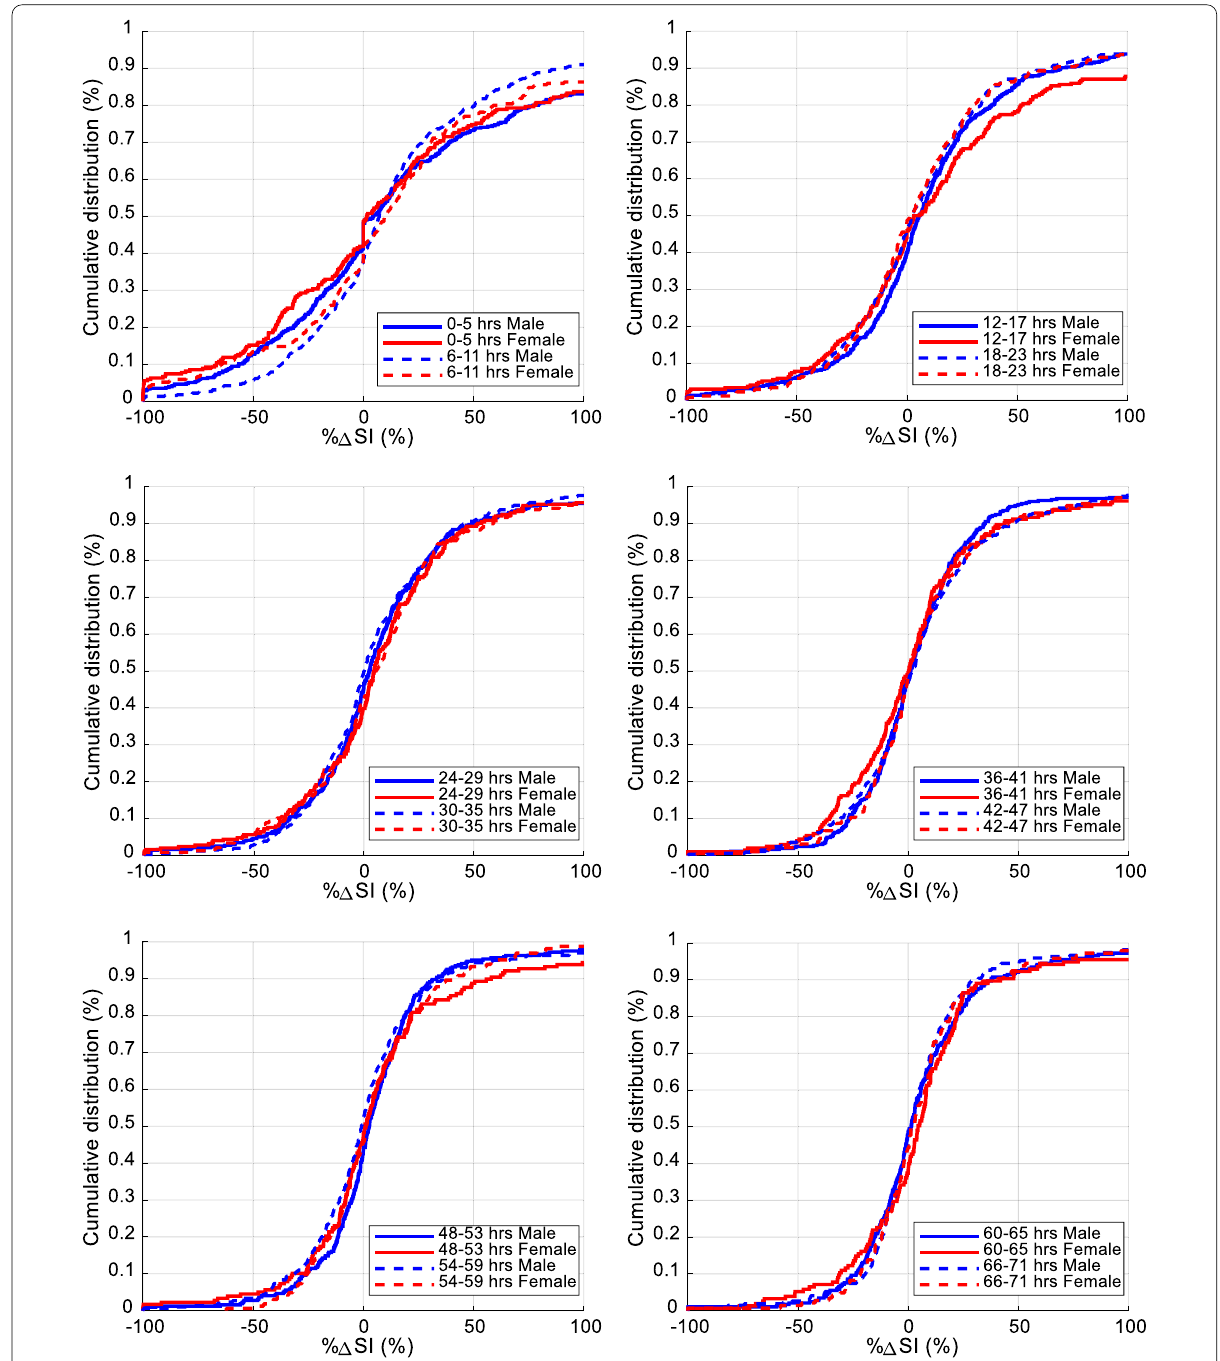
Fig. 6 Comparison of cumulative distribution of %ΔSI (%) levels between male and female over 6-h time intervals for the first 72 h of